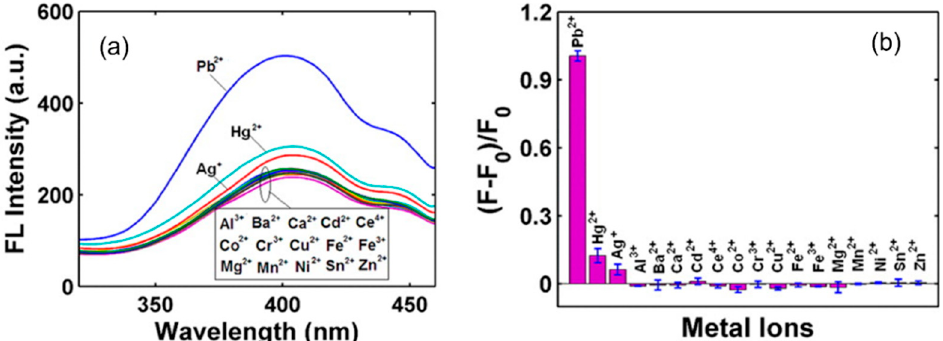
Figure 27. ( a ) Fluorescence spectra of MoS 2 with each metal ion. ( b ) Selectivity of MoS 2 for PB 2+ ions. Reproduced with permission from [77]. © American Chemical Society, 2016.